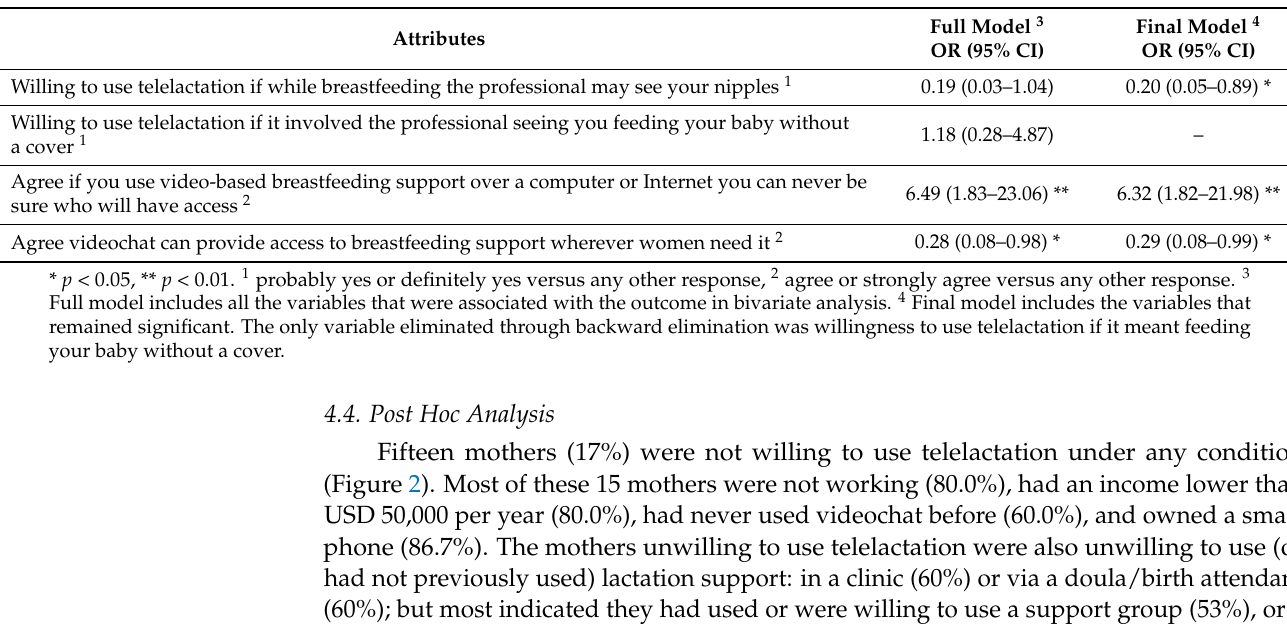
Table 4. Multivariable model: factors related to mothers agreeing or strongly agreeing to the statement “I do not feel comfortable with accessing video-based breastfeeding support